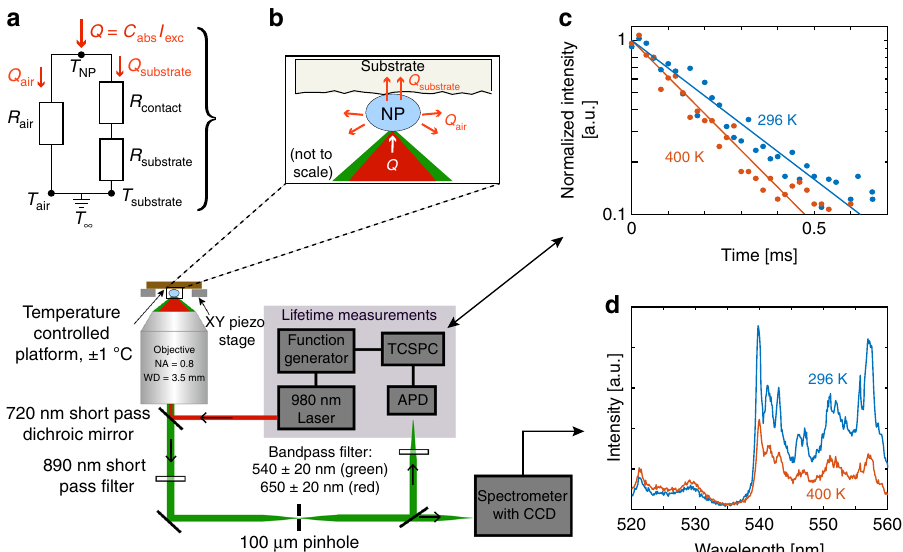
Fig. 1 Experimental apparatus and representative raw data. Luminescence intensity ratio and lifetime thermometry measurements of individual nanoparticles dispersed on a substrate. a Thermal circuit representation of experiments in which the luminescence intensity ratio or lifetime is measured as a function of I exc . To indicate that the substrate temperature is allowed to fl oat in these experiments, T substrate and T air are shorted together and grounded to the environment temperature, T ∞ . b Schematic of the sample con fi guration and experimental set-up for both these types of measurements. A spectrometer is used to record single-particle spectra for luminescence intensity ratio measurements. For luminescence lifetime measurements, an avalanche photodiode (APD) and a time-correlated single photon counter (TCSPC) are used. c Representative lifetime decay data at two temperatures, fi tted with single exponentials. d Representative spectra at two